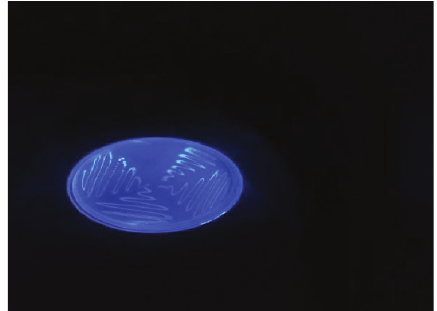
Figure 1: Fluorescent colony of Gluconacetobacter sp. RV28 under UV